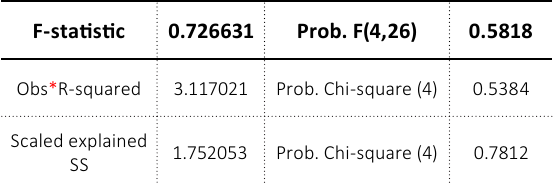
Table 3. Heteroskedasticity test: